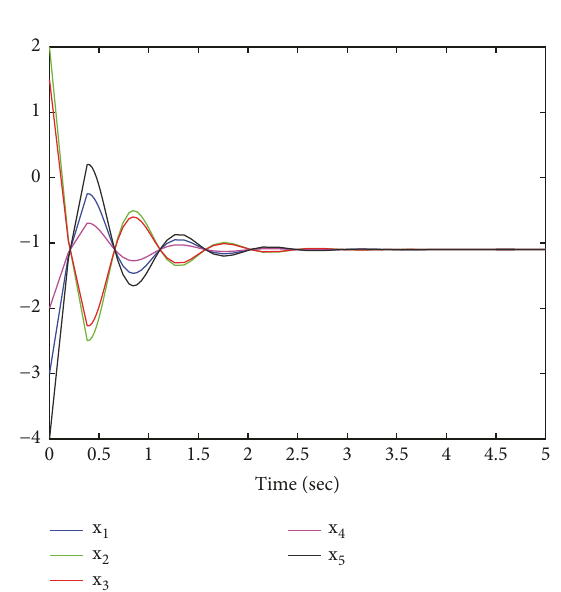
Figure 9: Sates of graph G , 𝜏 = 0.19𝑠 .